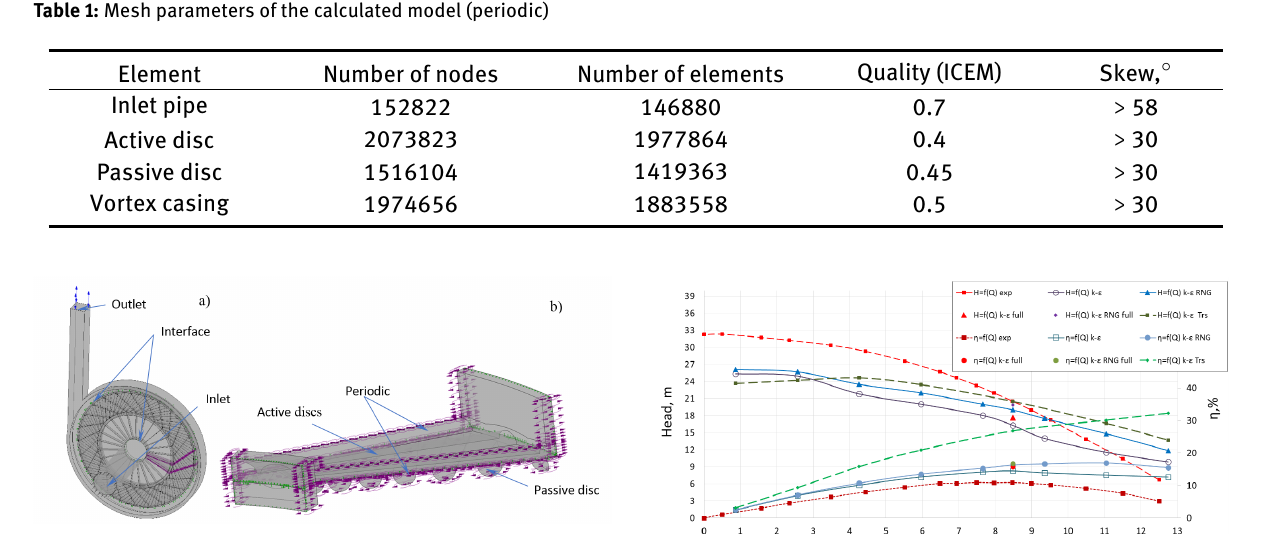
Table 1: Mesh parameters of the calculated model (periodic)